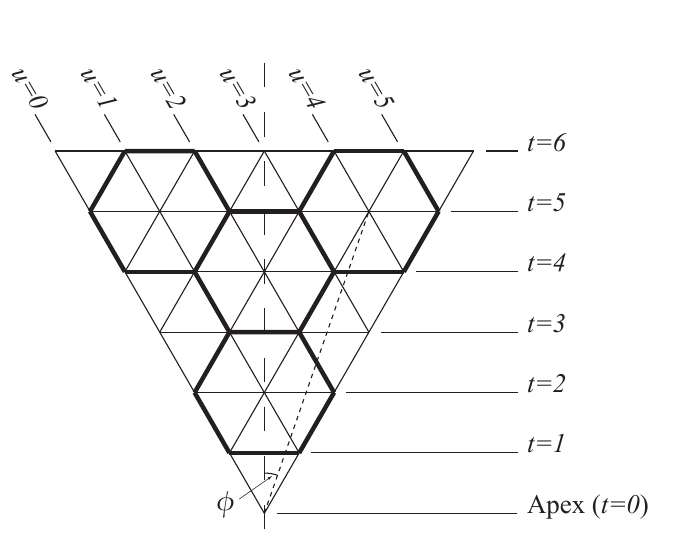
Figure 1. Geometry of a single panel (nanocones comprise from one to five such panels mapped onto a right circular